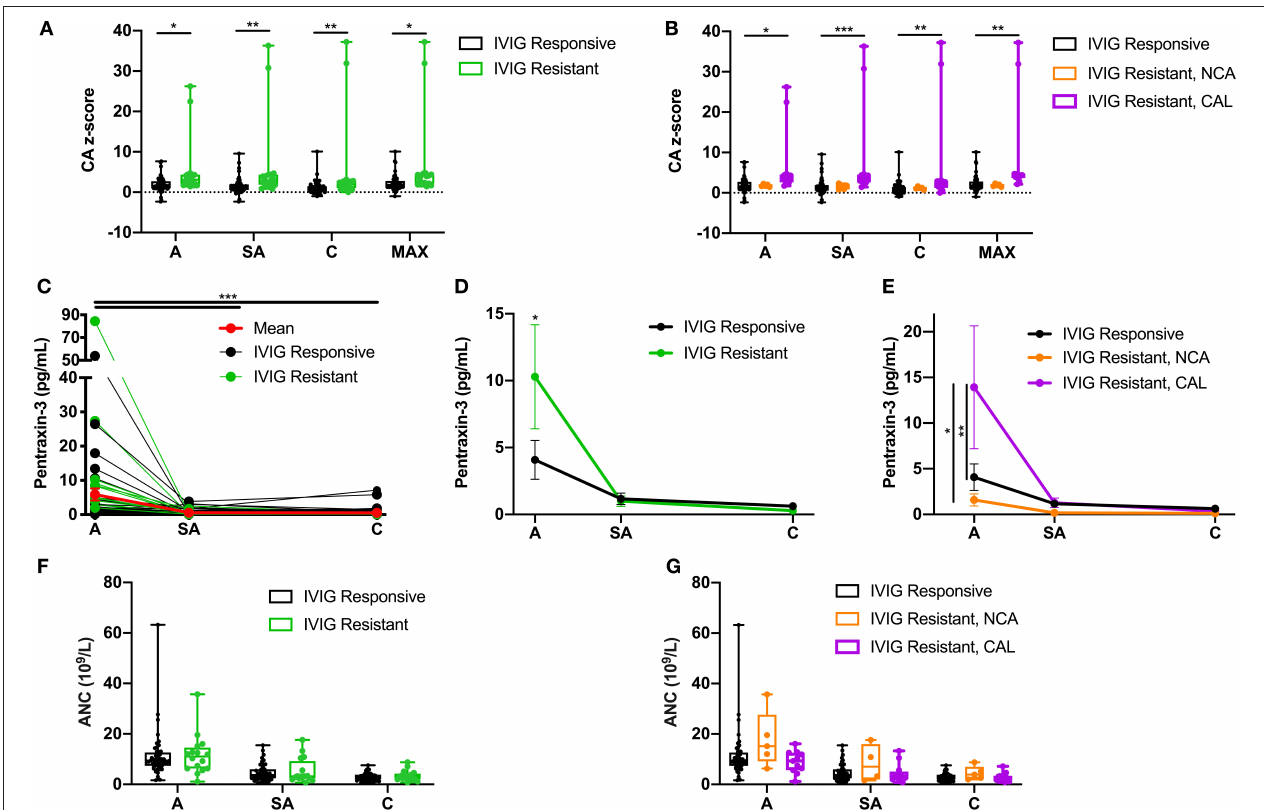
FIGURE 5 | Effects of intravenous immunoglobulin (IVIG) response on coronary artery z-scores, circulating PTX-3 levels, and absolute neutrophil count (ANC). (A) Coronary artery z-score among Kawasaki disease (KD) patients responsive to IVIG treatment (black; n = 52) and resistant to IVIG treatment (green; n = 18)